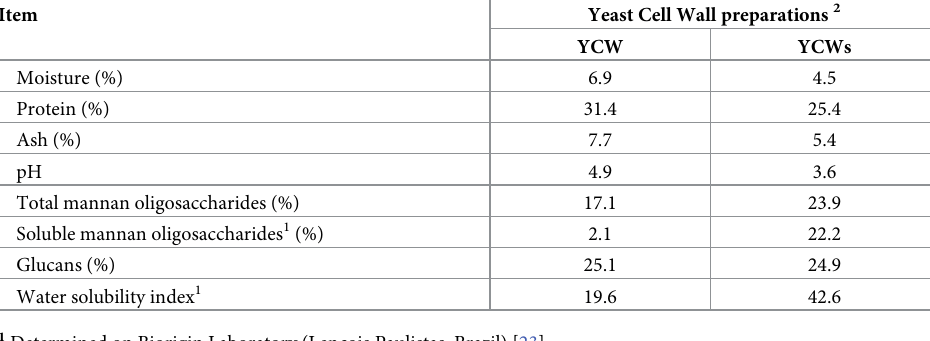
Table 1. Characteristics of the yeast cell wall derivates used on the